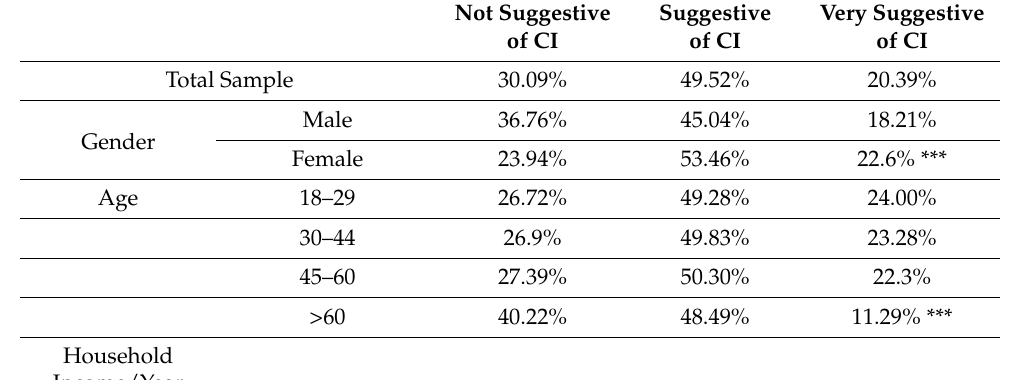
Table 3. Chemical intolerance prevalence by demographic group and mean scale scores (N =